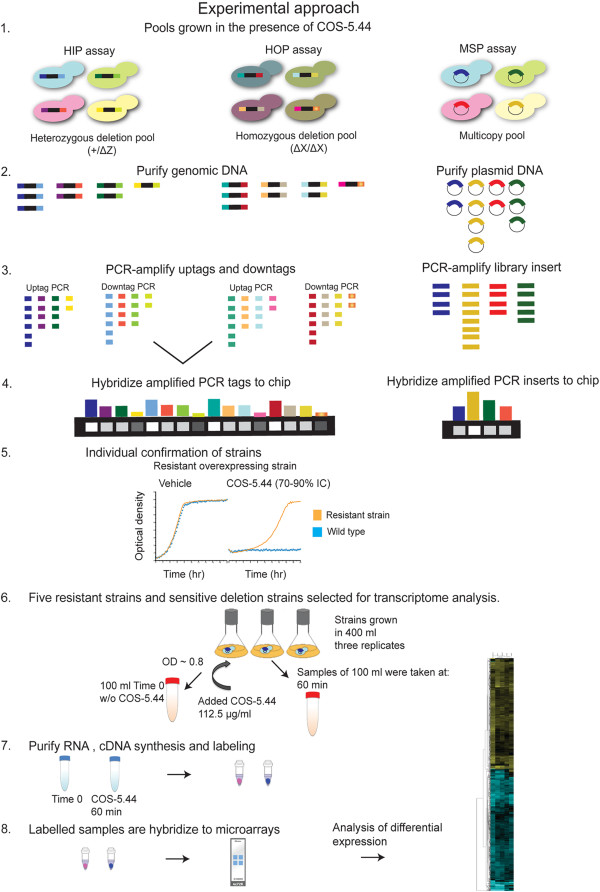
Experimental approach used to identify and characterize genes that confer resistance to chitosan oligosaccharide (COS). Three chemogenomic assays were used: Haploinsufficiency profiling (HIP), homozygous profiling (HOP) and multicopy suppression profile (MSP). (1) Heterozygous, homozygous deletion pools and multicopy suppression pool were grown competitively in the presence of COS-5.44. If a gene is required to grow in the presence of COS, the corresponding deletion strain will grow more slowly and therefore will be underrepresented. Cells overexpressing a gene that suppresses sensitivity will growth faster and will be overrepresented in the MSP pool. (2) Genomic DNA was isolated from cells prior to and after the HIP-HOP assays, and plasmid purification from the COS treated MSP pool was carried out. (3) Barcodes were PCR amplified for HIP-HOP assays as well as the plasmid inserts of MSP. (4) PCR products (barcodes and plasmid inserts) were hybridized to a TAG4 array. Intensity of treatment samples is compared with intensity of a control sample to determine relative abundance (~ fitness). (5) Sensitive deletion strains and constructed overexpressing strains were individually confirmed. (6) Five resistant overexpressing strains that were also sensitive as deletion strains were selected for transcriptome analysis. Overexpressing strains and vector control were grown in the presence of COS (112.5 μg/ml) and cells were harvested before COS treatment and after 60 min of COS treatment. (7) RNA was isolated from harvested cells, cDNA synthesized and labelled with fluorescent dyes. (8) Labelled samples were hybridized to expression microarrays. Transcriptional changes were indentified by differential expression analysis. Figure modified from Ericson et al. (2010).